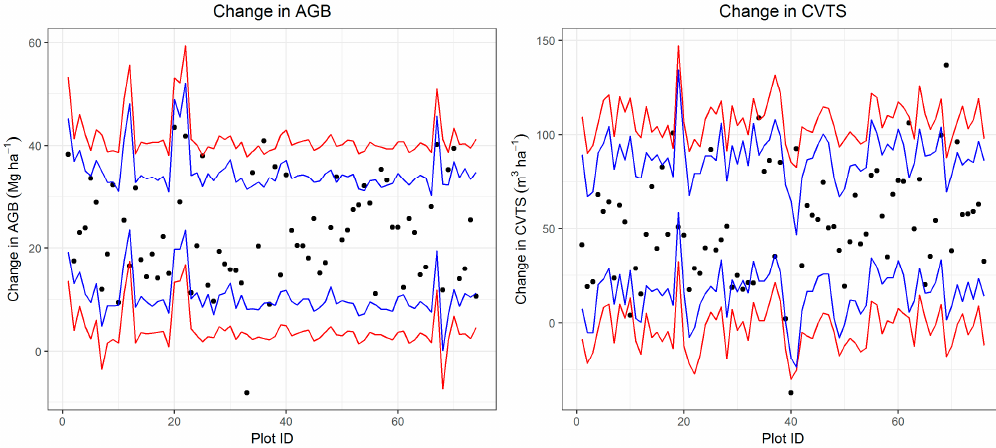
Figure 5. Prediction intervals obtained from Approach 2 (red) and Approach 5 (blue) in estimating change in aboveground biomass and cubic volume. Black points are the observed values of change in AGB and CVTS from 2007 to 2012.